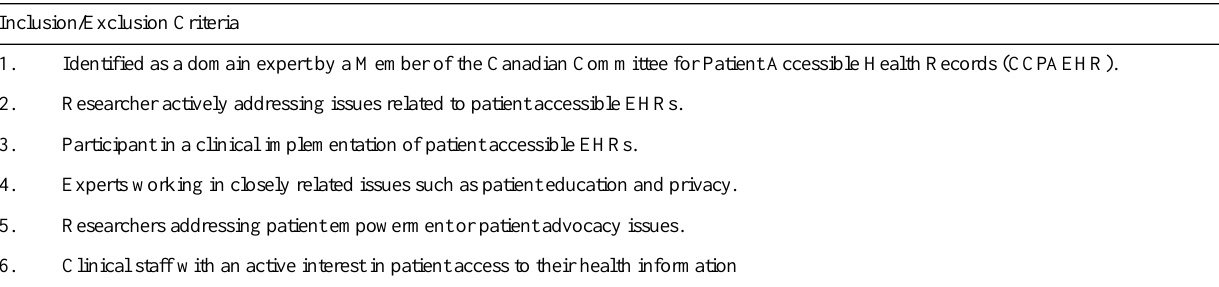
Table 1. PAEHR Workshop participants inclusion/exclusion criteria Inclusion/Exclusion